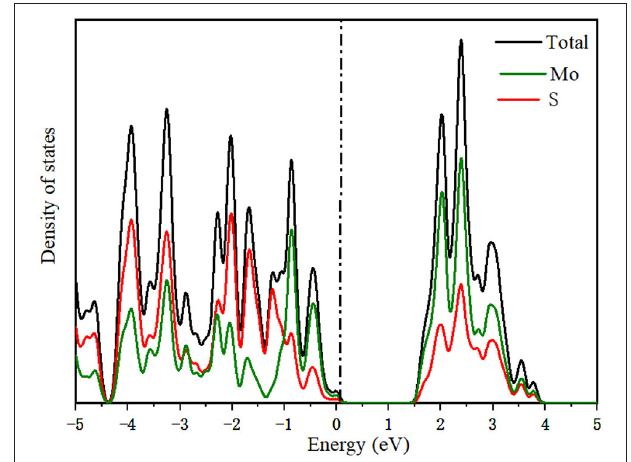
FIGURE 5 | The projected density of states in MoS 2